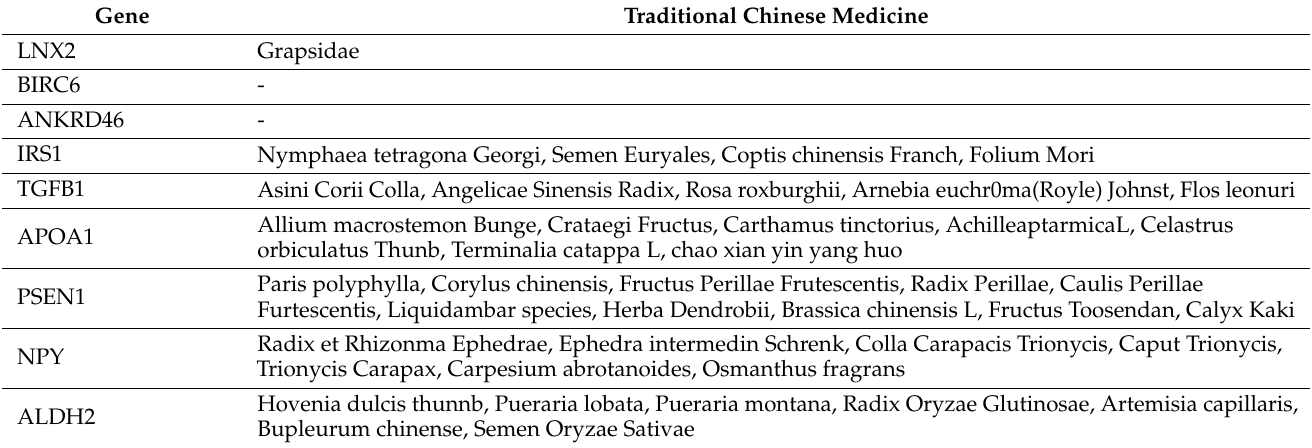
Table 5. Potential traditional Chinese